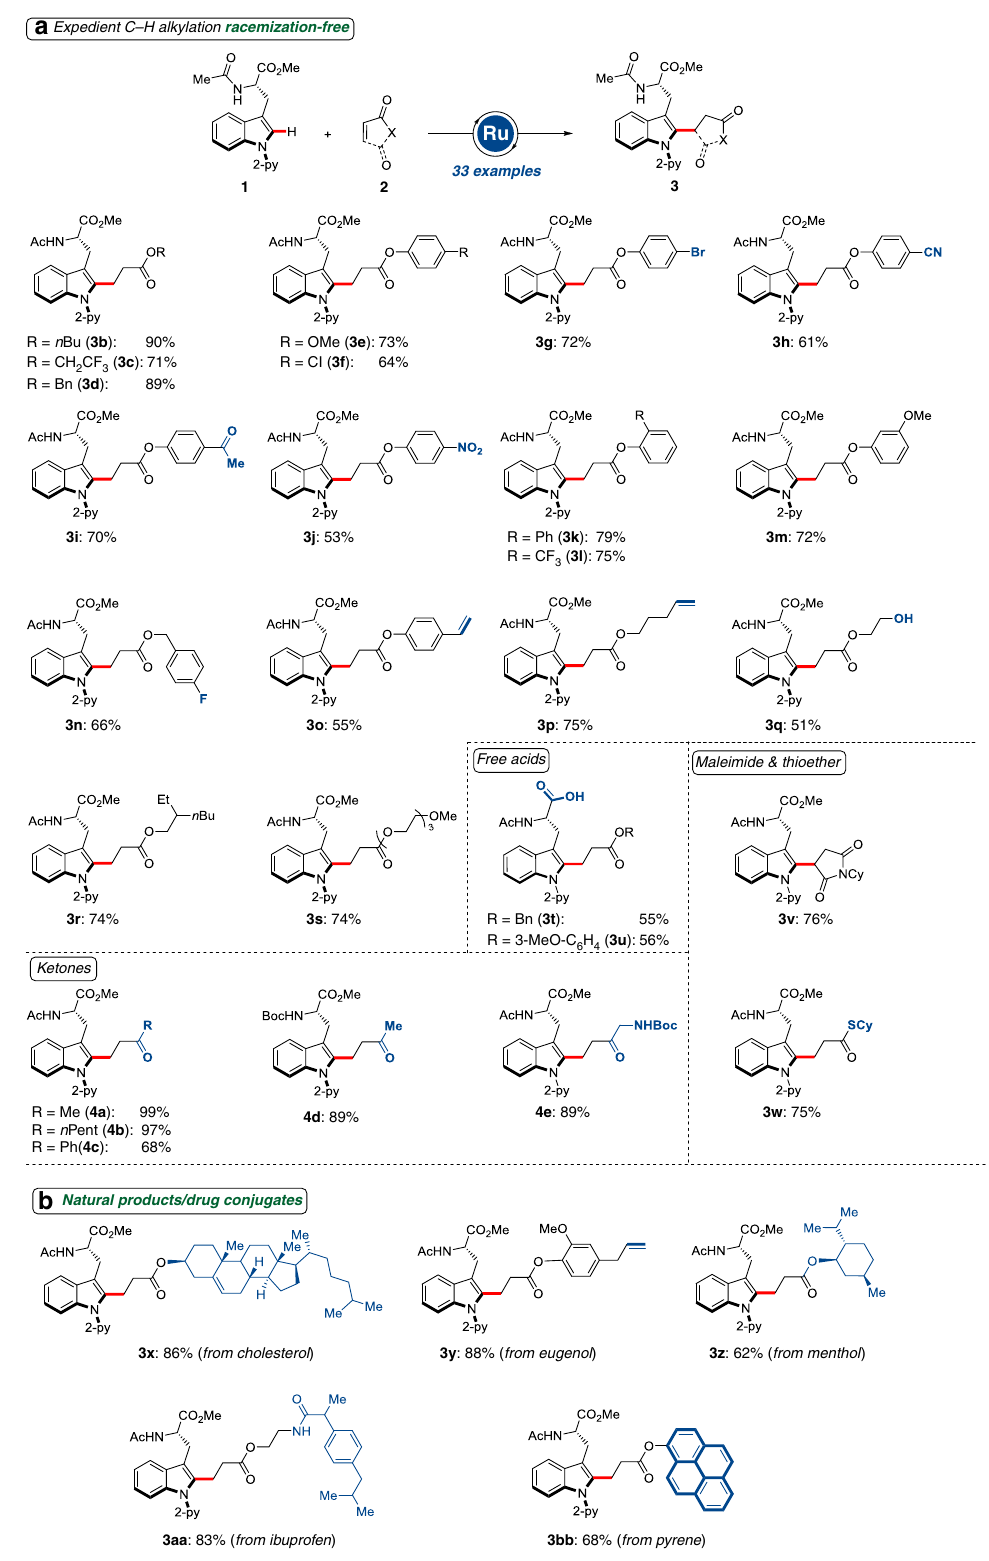
Fig. 3 Expedient ruthenium(II)-catalyzed amino-acid C – H alkylation. a Ruthenium(II)-catalyzed C – H alkylation with alkenes 2 ; b ruthenium(II)-catalyzed C – H alkylation for amino-acid conjugates featuring natural products and